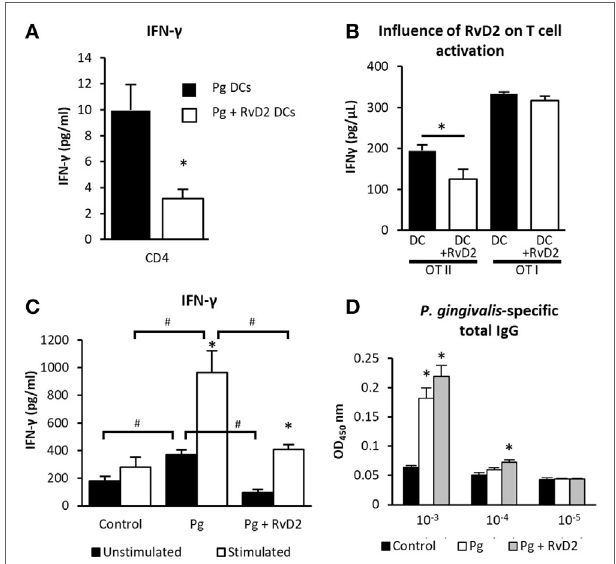
FigUre 2 | Resolvin D2 inhibits T-cell IFN- γ spontaneous secretion. (a) 4 days after the last exposure, CD11c + APCs from cervical lymph nodes from Pg or Pg + RvD2 groups, were isolated and challenged with CD4 + T-cells harvested from the lymph nodes of naive mice, then those cells were incubated for 72 h, at 37°C, 5% CO 2 and IFN- γ was measured in the supernatant. Data represent the mean ± SEM of two independent experiments. (B) APCs were enriched from the lymph nodes of B6 mice and challenged with CD4 + cells enriched from OT II or CD8 + cells enriched from OT I mice, and then cultured together in the presence of its specific antigen with or without RvD2 and incubated for 72 h, at 37°C, 5% CO 2 . The levels of IFN- γ in the supernatants were quantified by ELISA. Data represent the mean ± SEM of two independent experiments. (c) Six weeks after infection, splenocytes were harvested and incubated (2 × 10 6 cells per well) with or without RgpB antigen for 72 h, the levels of IFN- γ in the supernatants were quantified by ELISA. The presented data represent the means of six mice per group ± SEM. Results are representative of two independent experiments. (D) Serum was collected 6 weeks after infection and total Porphyromonas gingivalis- specific IgG was tittered with ELISA. The presented data represent the means of six mice per group ± SEM. Results are representative of two independent experiments, * p < 0.05 # p <